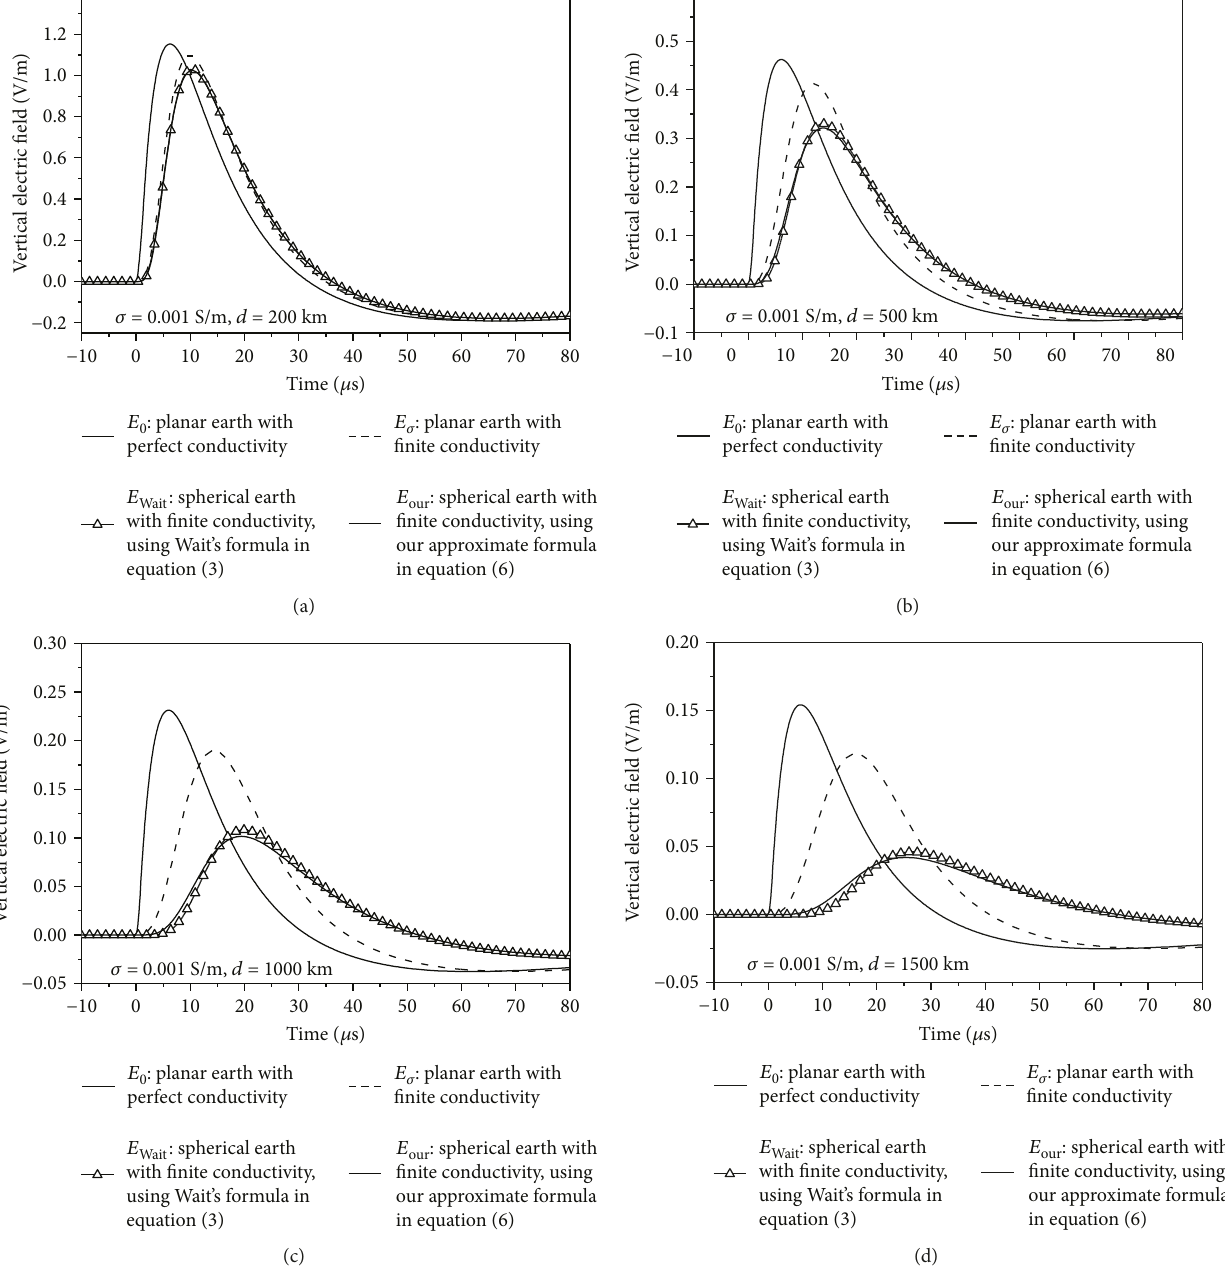
Figure 5: Similar to that of Figure 3 but for fi nite conductivity of 0.001S/m at the di ff erent distances of (a) 200km, (b) 500 km, (c) 1000km, and (d) 1500